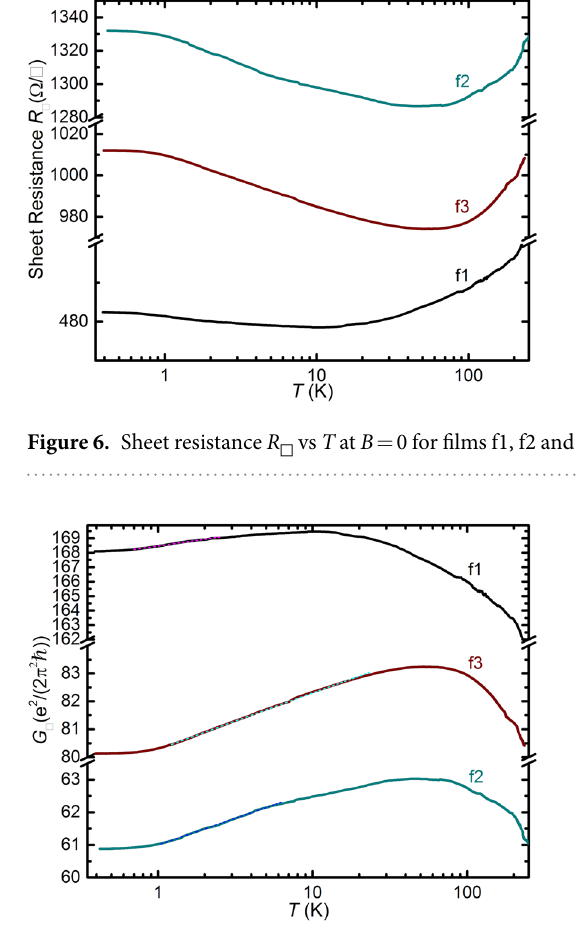
Figure 7. Sheet conductance G vs T at B = 0 for films f1, f2 and f3 (solid lines, films as indicated), with fits to □ the low- T data using Equation (1) (dashed lines).